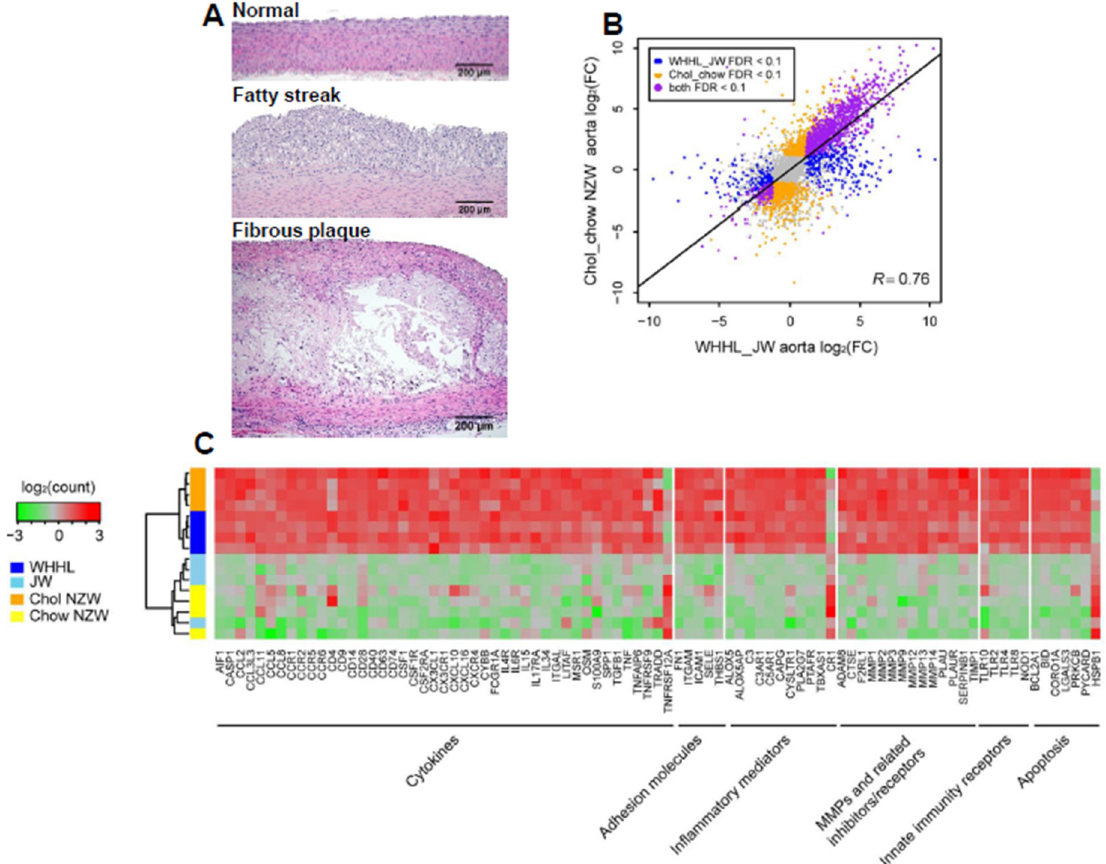
Figure 1. Representative micrographs of rabbit aortic atherosclerosis ( A ). Normal ( top ), fatty streak ( middle ) and fibrous plaque ( bottom ). Aortic lesions of atherosclerosis were stained with hematoxylin and eosin staining. Transcriptome profiling of rabbit models with aortic atherosclerosis ( B ). Transcriptomic profiling of aortas from chow-fed NZW and cholesterol-fed NZW, and chow-fed JW and Watanabe heritable hyperlipidemic (WHHL) rabbits were conducted and a strong positive correlation of expression changes in the aorta between cholesterol-fed and WHHL rabbits is shown in ( B ). FDR: false discovery rate, FC: fold change. The correlation coefficient was calculated for differentially expressed genes (DEGs) in at least one condition. Heatmap of representative DEGs responsible for inflammation responses in the aorta was shown ( C ). The read counts were log-transformed and normalized across samples ( C ). ( B , C ) are modified from the original published figures [15].